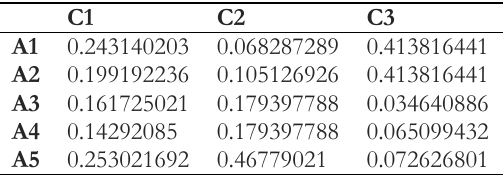
Table 6. The priority weights of alternative services with respect to criteria.